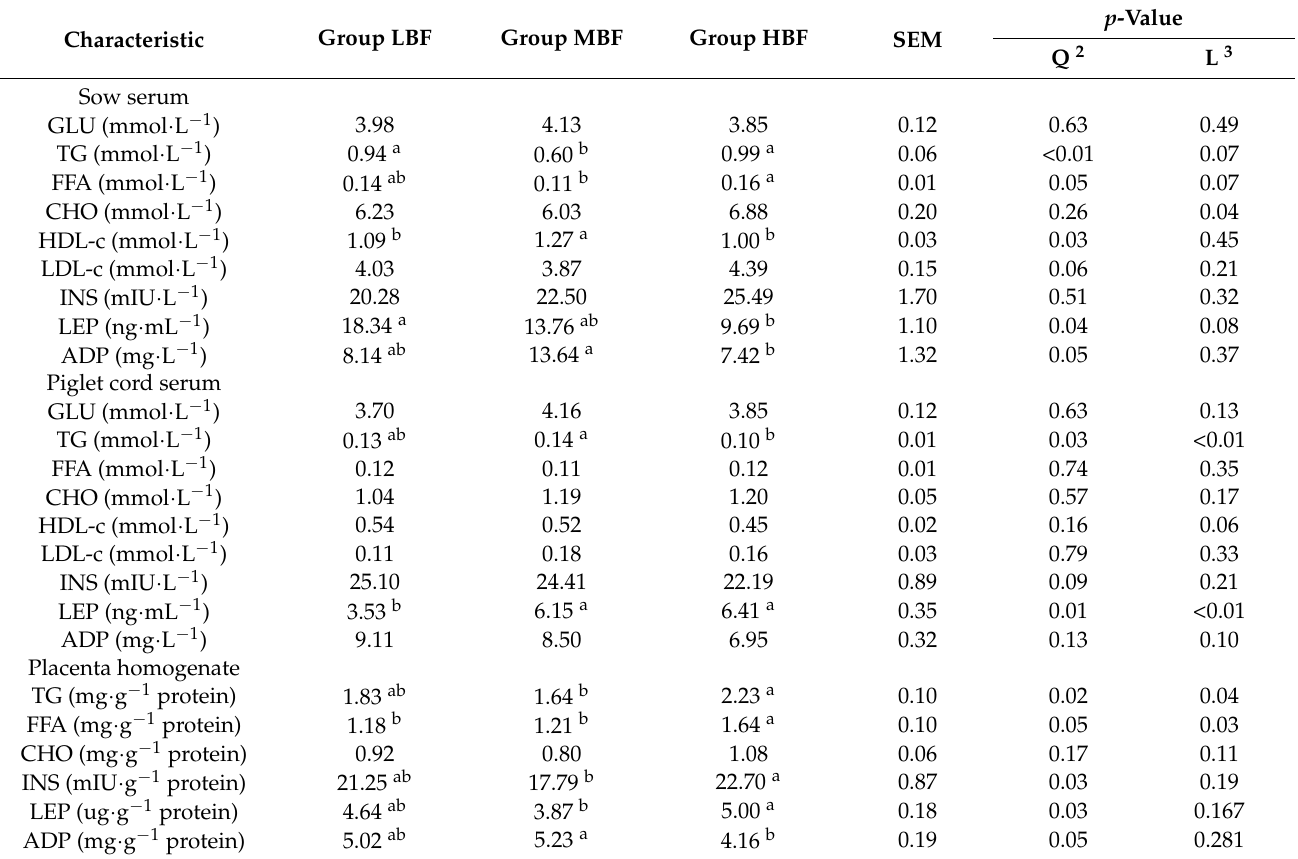
Table 2. The concentrations of lipids, lipid-related hormones, and adipokines in sow serum, piglet cord serum, and placenta homogenate 1